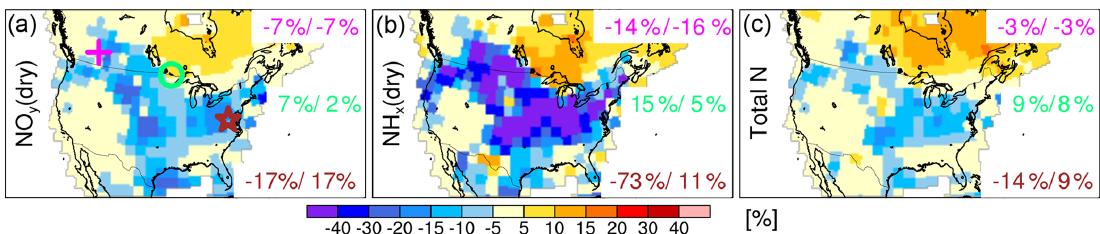
Figure 6. Relative change in the 2008–2010 average land deposition of dry oxidized nitrogen (a) , dry reduced nitrogen (b) , and total nitrogen (c) associated with anthropogenic land-use change. The relative change is shown as (with land use − without land use) / with land use. From top right to bottom right, the percentages indicate the change in N deposition at Banff National Park (cross), Voyageurs National Park (circle), and Shenandoah National Park (star) at the grid-box level and on natural vegetation, a better proxy for these parks.